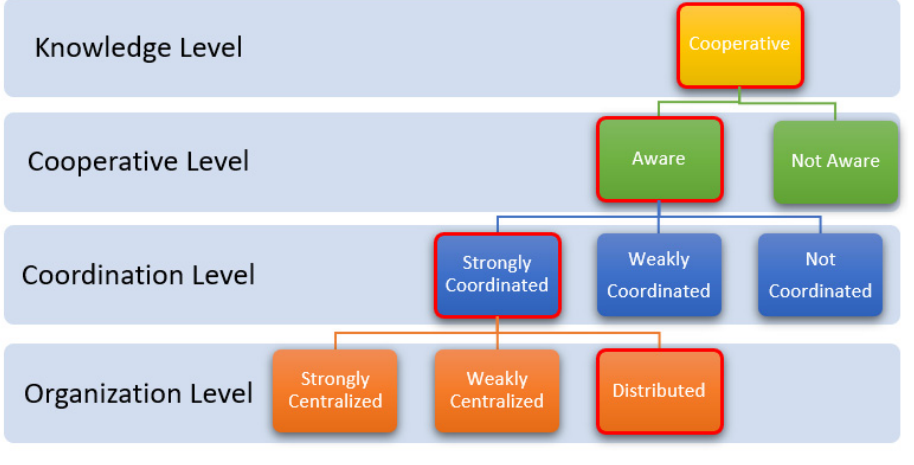
Figure 1. Characteristics of swarm robots [1].